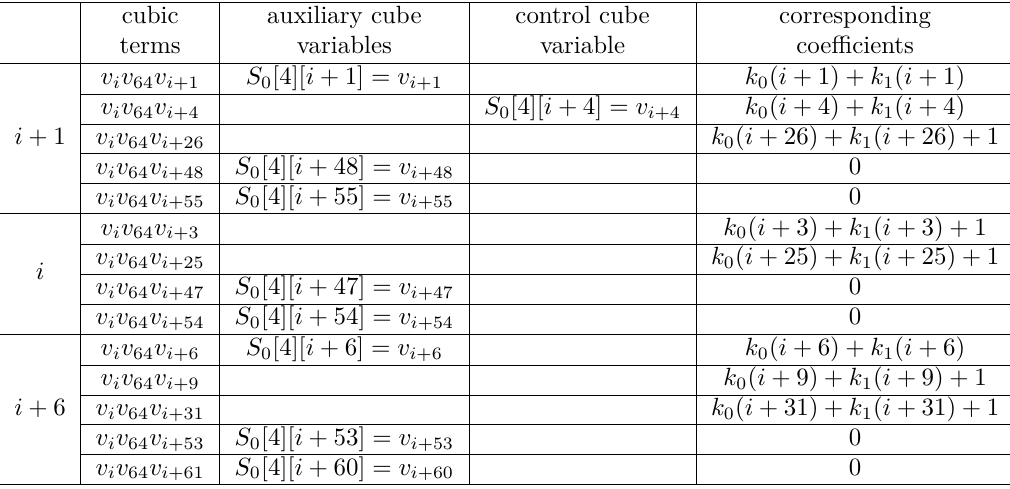
Table 6: Coefficients of Cubic Terms with Auxiliary and Control Cube Variable cubic auxiliary cube control cube corresponding terms variables variable